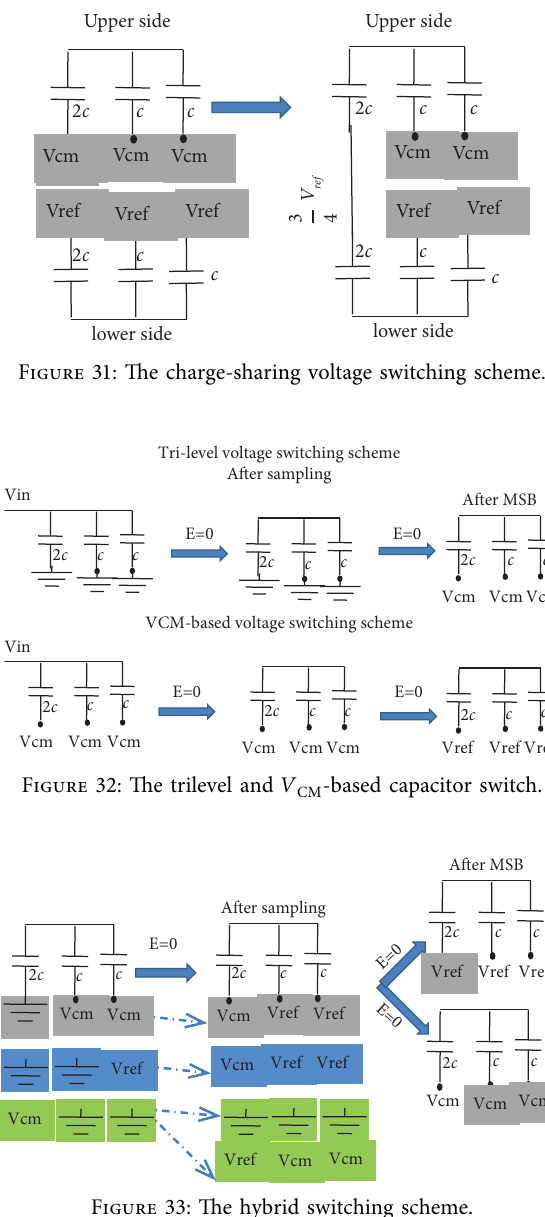
Figure 33: Te hybrid switching scheme.